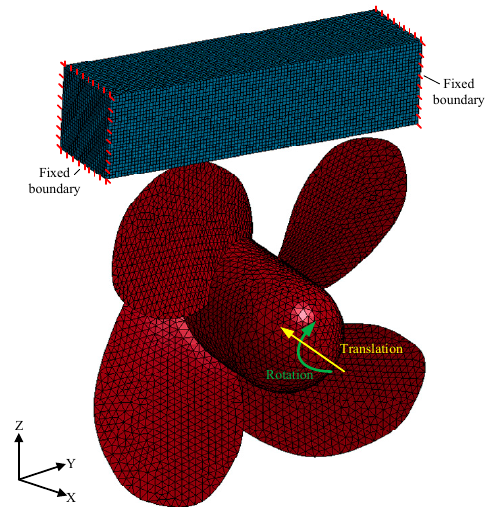
Figure 9. The configuration of ice-propeller milling.